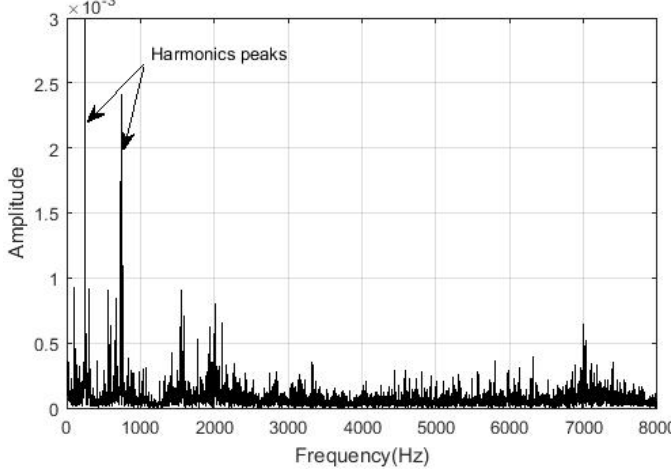
Figure 11. Healthy rotor spectrum before the noise reduction with the harmonic peaks.